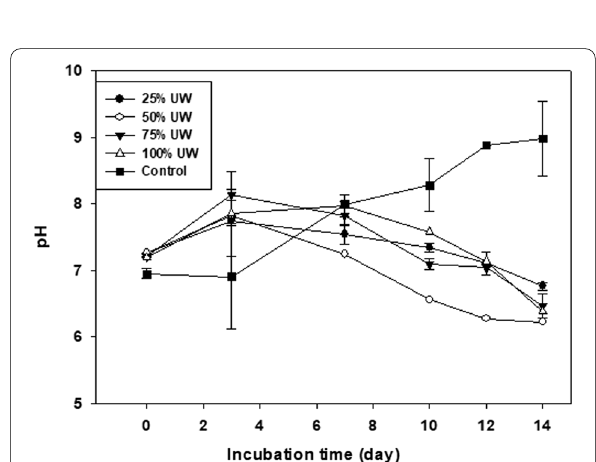
Fig. 2 Evolution of pH throughout the incubation period (14 days), in the different treatments (control, 25% UW, 50% UW, 75% UW, and 100% UW). Data are expressed as mean